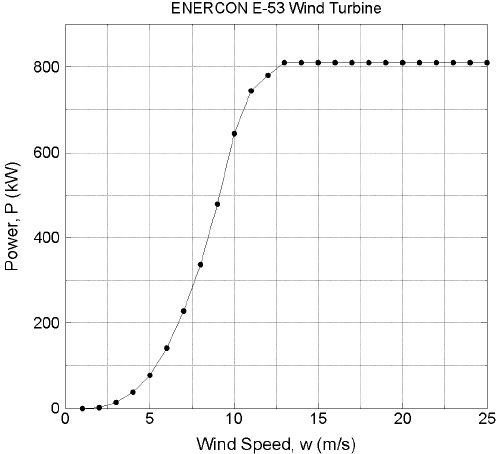
Figure 7. Power curve of the selected wind turbine.